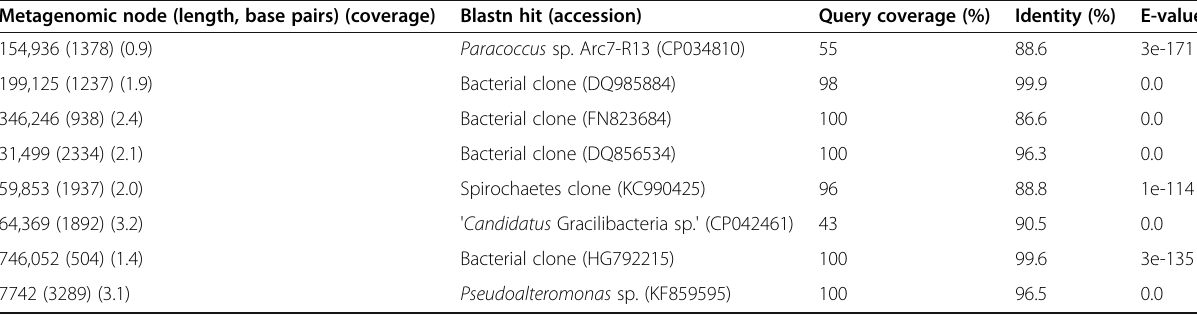
Table 3 Metaxa2 results after mining the metagenomic data for bacterial SSU and LSU sequences Metagenomic node (length, base pairs) (coverage) Blastn hit